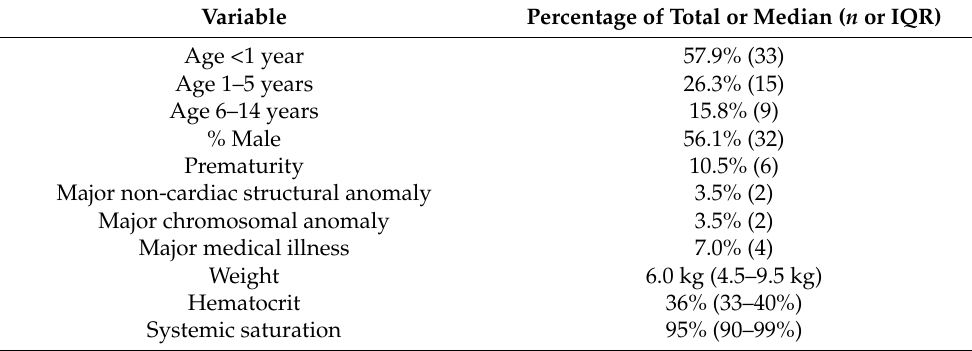
Table 2. Cohort demographics and extra-cardiac anomalies. The predominant age was less than 1-year and males accounted for slightly more than half of the cohort. On average, the children had normal hematocrits and saturations. 14 children carried diagnoses outside of congenital heart